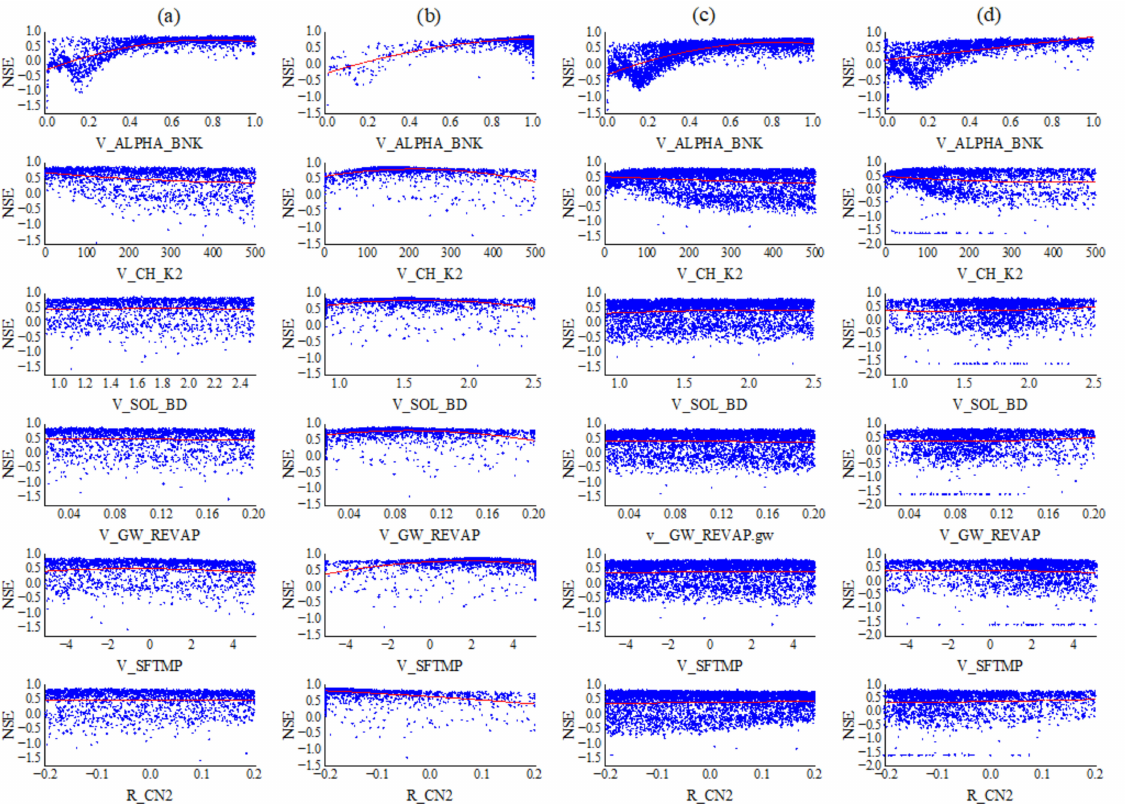
Figure 6. Scatter plots of the parameter combinations obtained by SUFI-2 ( a ), ParaSol ( b ), GLUE ( c ), PSO ( d ), and the NSE values. (The red line is calculated based on the weighted average of all parameter